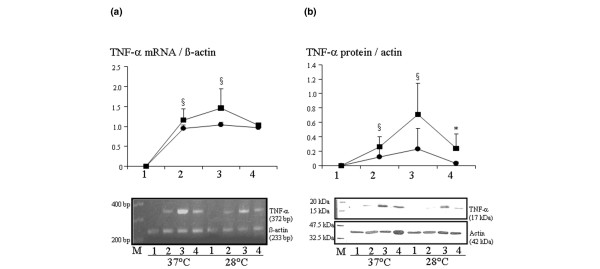
TNF-α mRNA expression and TNF-α concentration: hypothermia versus normothermia. Shown are the expression of TNF-α mRNA and TNF-α concentrations in pigs operated on under moderate hypothermia (28°C; circles) or normothermia (37°C; squares). The time points of evaluation were as follows: 1 = before CPB; 2 = before aortic cross clamping; 3 = before removal of aortic clamp; and 4 = 6 hours after CPB. (a) In the upper panel, showing TNF-α mRNA findings, results are given as mean ± standard deviation. §P < 0.1. Lower panel: gel showing the effect of temperature on myocardial expression of TNF-α mRNA; results are representative of six independent experiments in each group. (b) In the upper panel, showing TNF-α protein concentrations, results are given as mean ± standard deviation. *P < 0.05, §P < 0.1. Lower panel: gel showing the effect of temperature on myocardial expression of TNF-α, as detected by Western blot. Band intensities for TNF-α were normalized for band intensities for actin. Results are representative of six independent experiments in each group (28°C = hypothermia, 37°C = normothermia). bp, base pairs; CPB cardiopulmonary bypass; M, molecular weight markers; TNF, tumour necrosis factor.